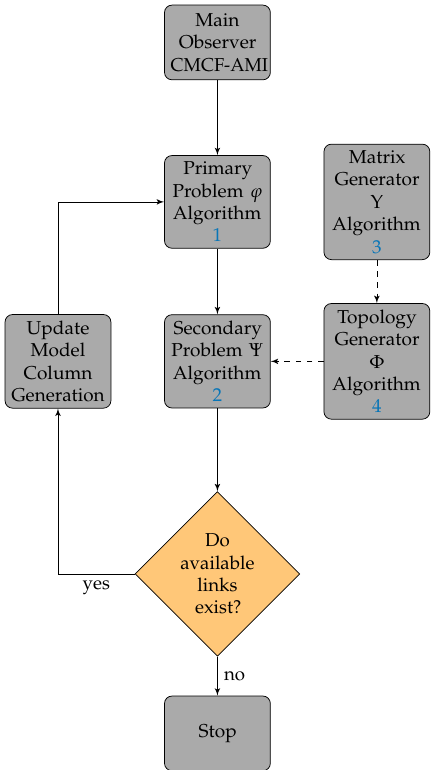
Figure 2. Flowchart for the CMCF-AMI model or main observer CMCF-AMI.